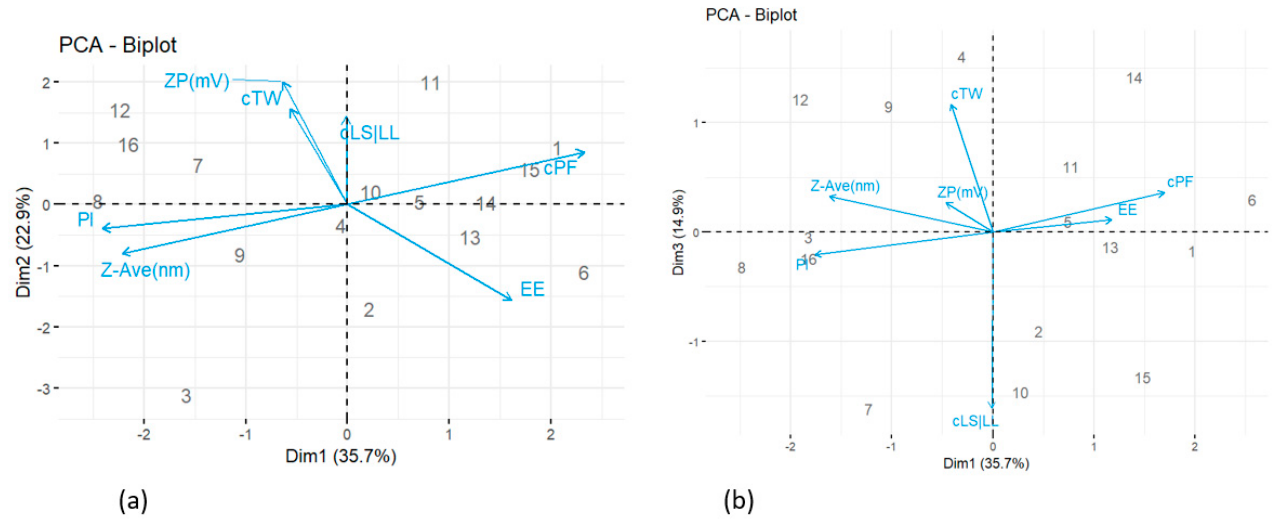
Figure 2. Biplots of ( a ) the First and Second Principal Component; ( b ) the First and Third Principal Component.